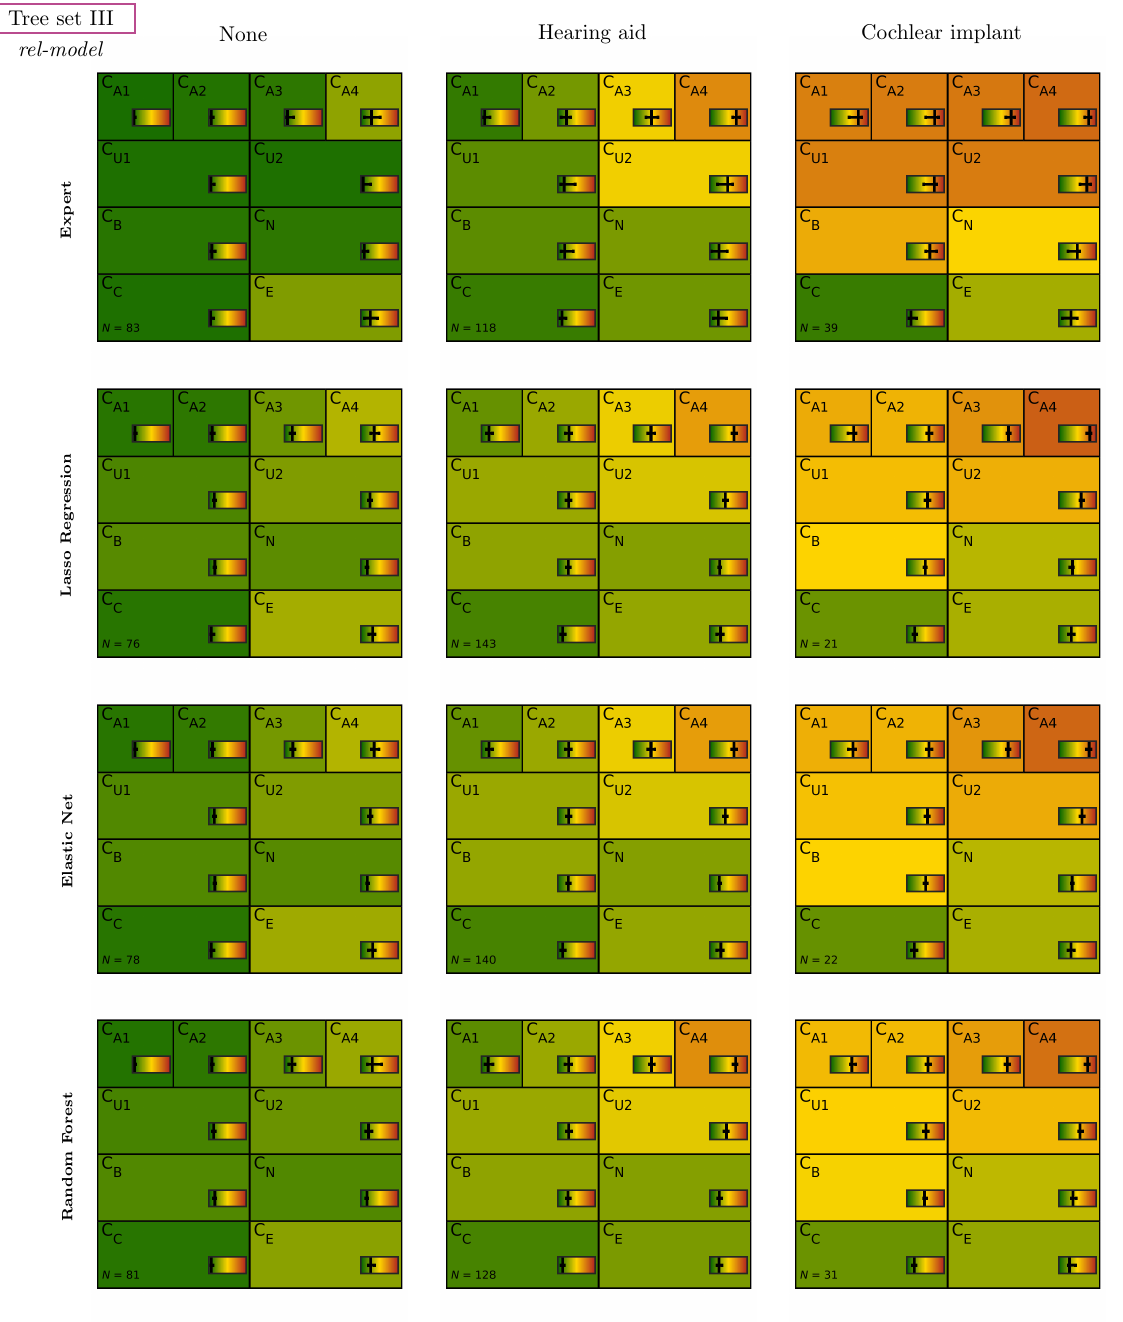
Figure 7. CAFPA patterns (median and interquartile ranges) of patients classified in tree set III for expert and all models (rows) using rel-model weights. N indicates the number of included patients. CAFPAs for tree sets I and II and different weights are provided in the Supplemental